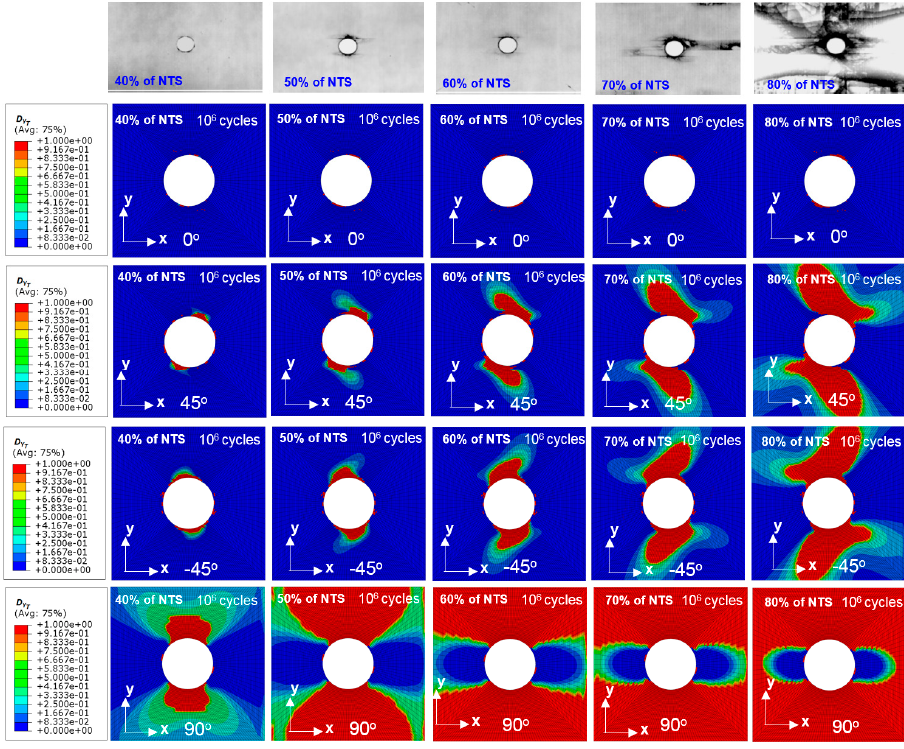
Figure 16. Reduction in strength Y T in each ply of the OHT specimen after 10 6 cycles.